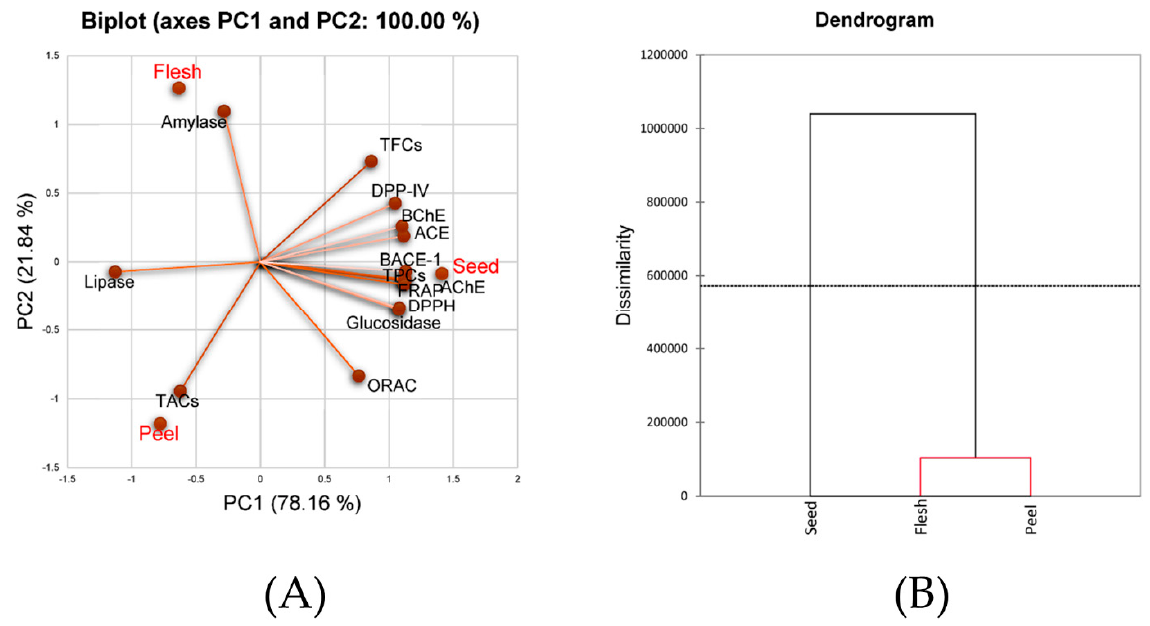
Figure 2. ( A ) Biplot of principal component analysis (PCA) generated from the observations including aril (flesh), pericarp (peel) and seed of Nephelium hypoleucum Kurz and variables including total phenolic contents (TPCs), total anthocyanin contents (TACs), total flavonoid contents (TFCs), antioxidant activities (DPPH radical scavenging, FRAP and ORAC activities) and enzyme inhibitory activities against lipase, dipeptidyl peptidase-IV (DPP-IV), α -glucosidase, α -amylase, angiotensin-converting enzyme (ACE), β -secretase (BACE-1), butyrylcholinesterase (BChE) and acetylcholinesterase (AChE); ( B ) dendrogram derived from the hierarchical cluster analysis (HCA) from the same data as PCA. The obtained biplots showed two axes including PC1 and PC2 (Figure 2A).